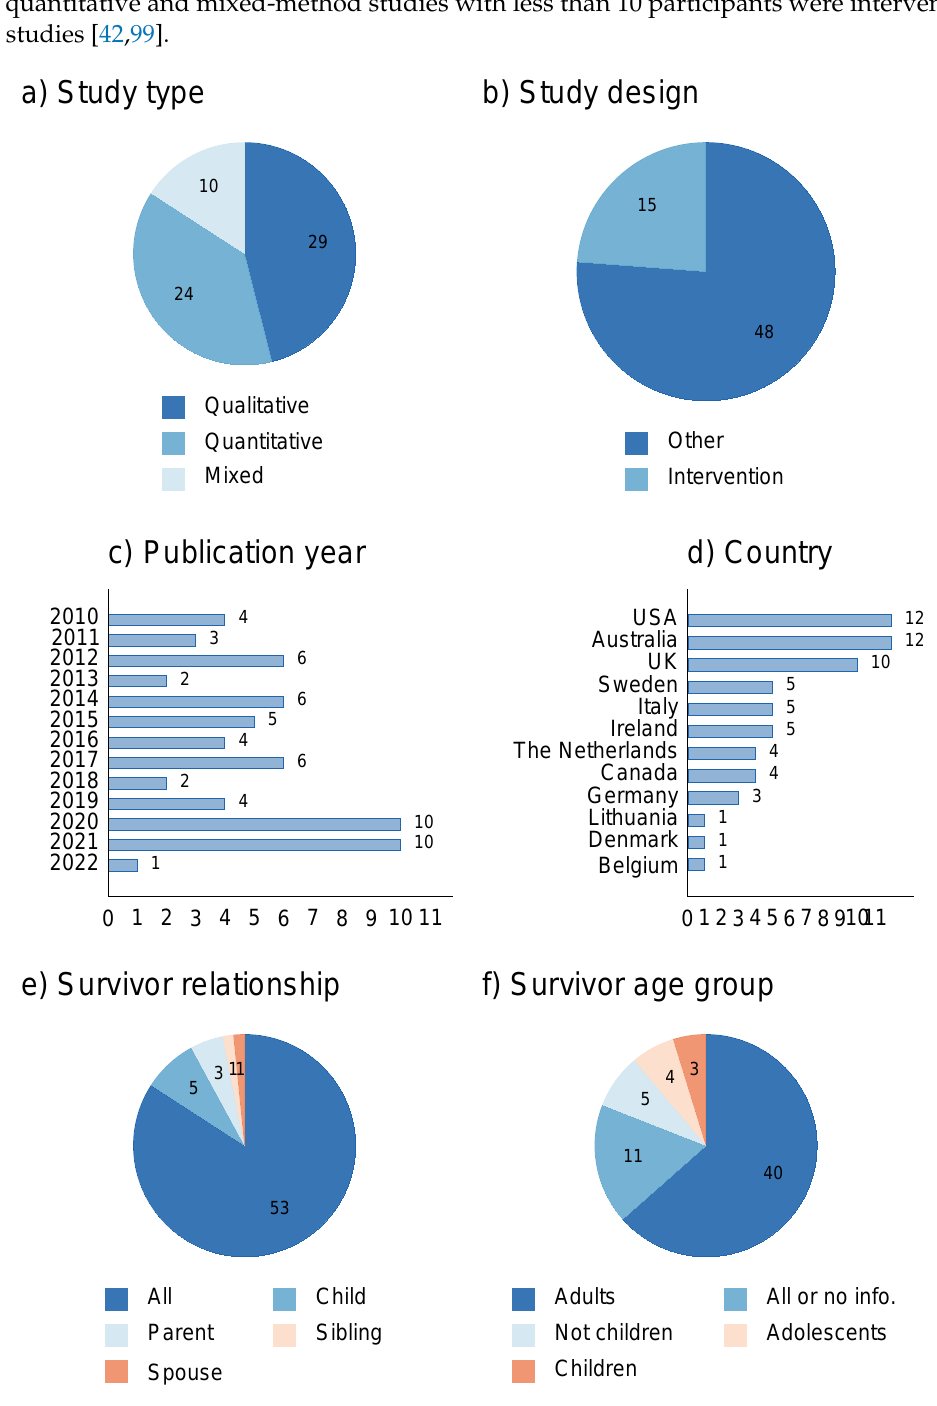
Figure 2. Study characteristics for study type, study design, year of publication, countries (based on affiliation of first author), survivor relationship to the deceased, survivor age group. Number of studies. N = 63.